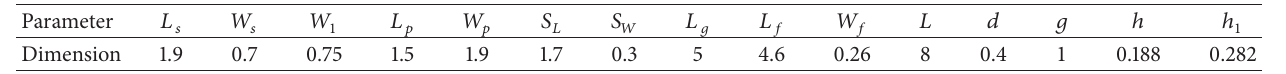
Figure 3: The simulated and measured return losses of the patch antennas with and without SPSs. Table 1: The final optimized dimensions of the proposed antenna (unit: